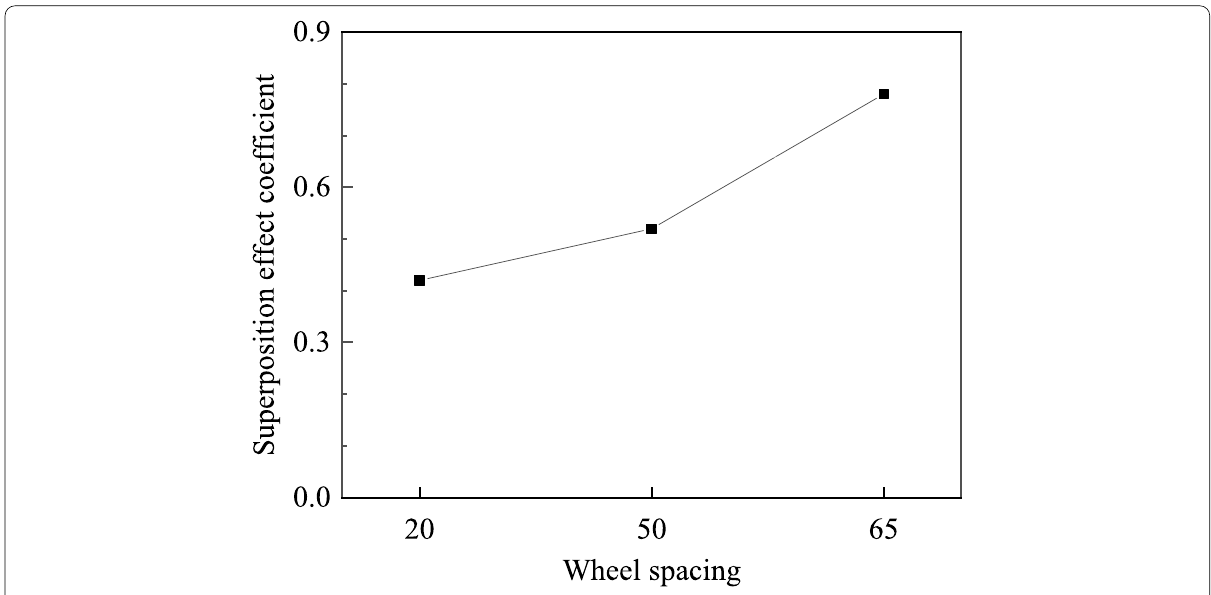
Fig. 14 Superposition effect coefficient at different wheel